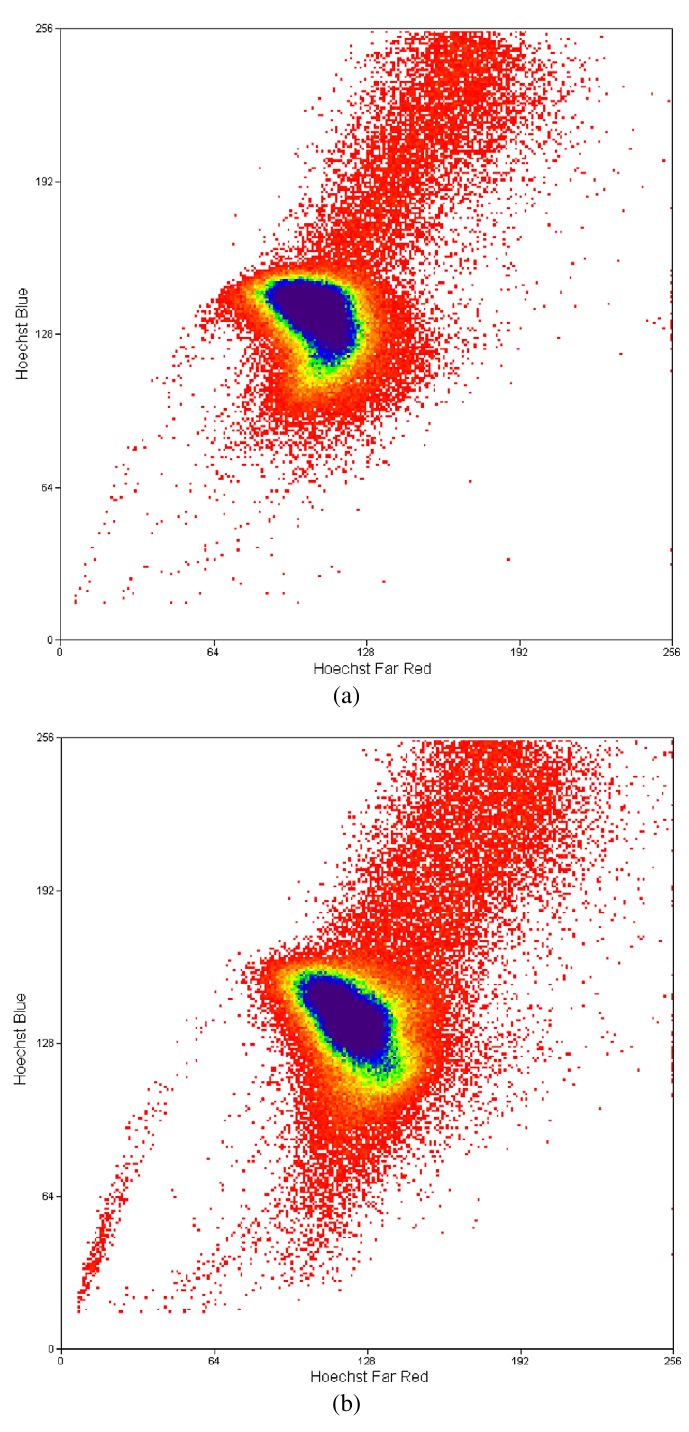
Fig. 5. Effect of Hoechst concentration on the SP cells counting. The same bone marrow sample was stained using different concentrations of Ho342: 2.5 µ g/ml (a), 5 µ g/ml (b) and 10 µ g/ml